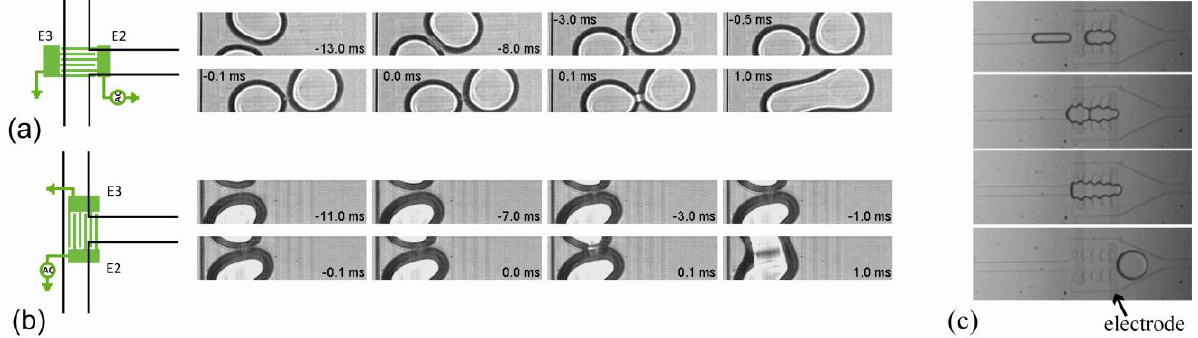
Figure 14. ( a ) and ( b ) Droplet merging on different orientations of the interdigitated electrodes. Reprinted from [119] with permission from the American Institute of Physics (AIP). ( c ) Droplet are stopped by pillar array and merged by EC. Reprinted from [110] with permission from American Chemical Society